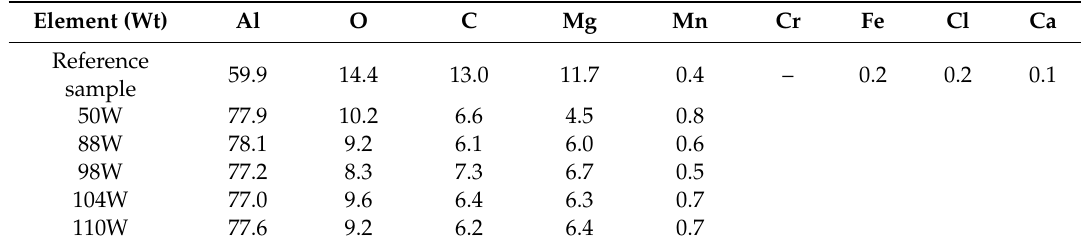
Table 3. Element content of aluminum alloy samples under di ff erent powers by an energy dispersive